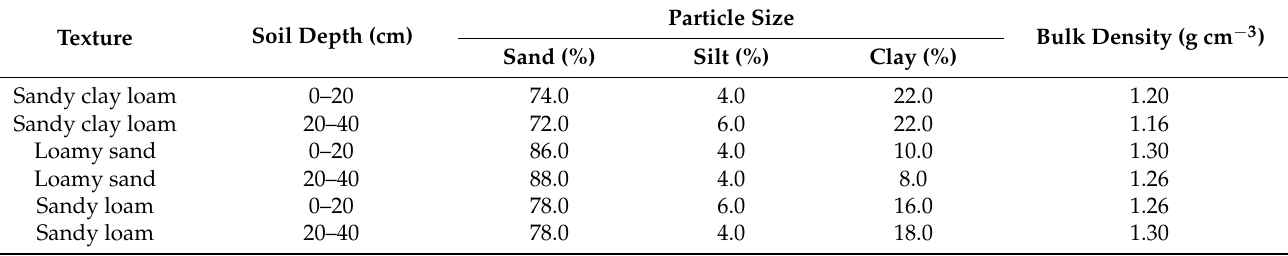
Table 11. Physical properties of the experimental